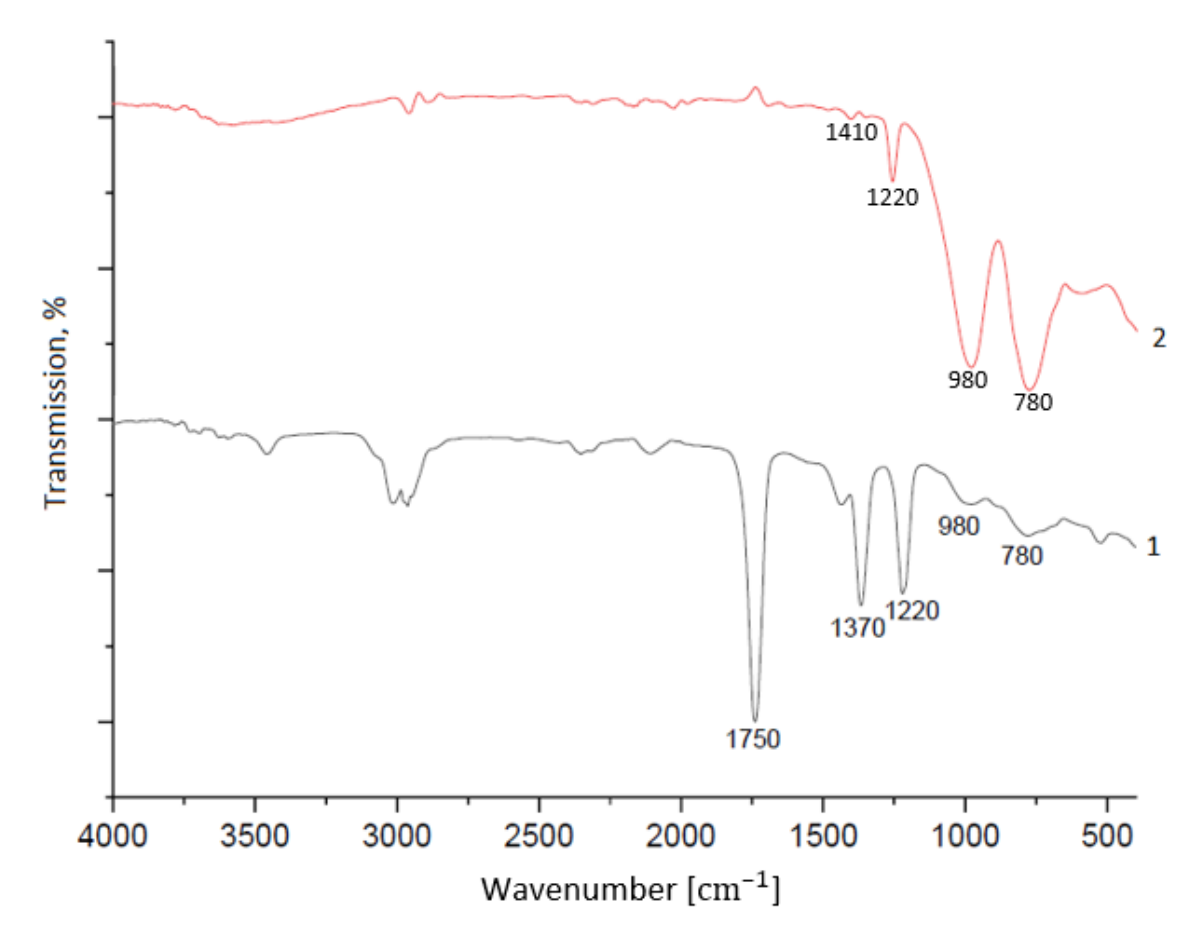
Figure 11. Results of IR-spectroscopy of the PCS fibers before (1) and after (2) TMA. After TMA, signals at 1370, 1750, and 2960–3020 cm − 1 , part of which are related to oxygen-containing bonds, disappear. These changes also correlate with both the results of mass spectroscopy and the compressed fiber transformation. The persistence of the irreversible deformation of the PCS sample after TMA, albeit to a lesser extent than in the case of the PAN sample (Figure 10), explains the increase in the elastic modulus of the compressed region during TMA; formations protrude onto the surface of the filaments and interact with each other autohesively to fix the gradual transformation of individual fibers into a single whole. Therefore, the insular nature of the self-bonding areas of the fibers does not prevent the formation of dense and highly processible reinforcing silicon carbide frames of various reinforcement structures that proceed from organic to inorganic state, accompanied by their shrinkage as a whole (Figure